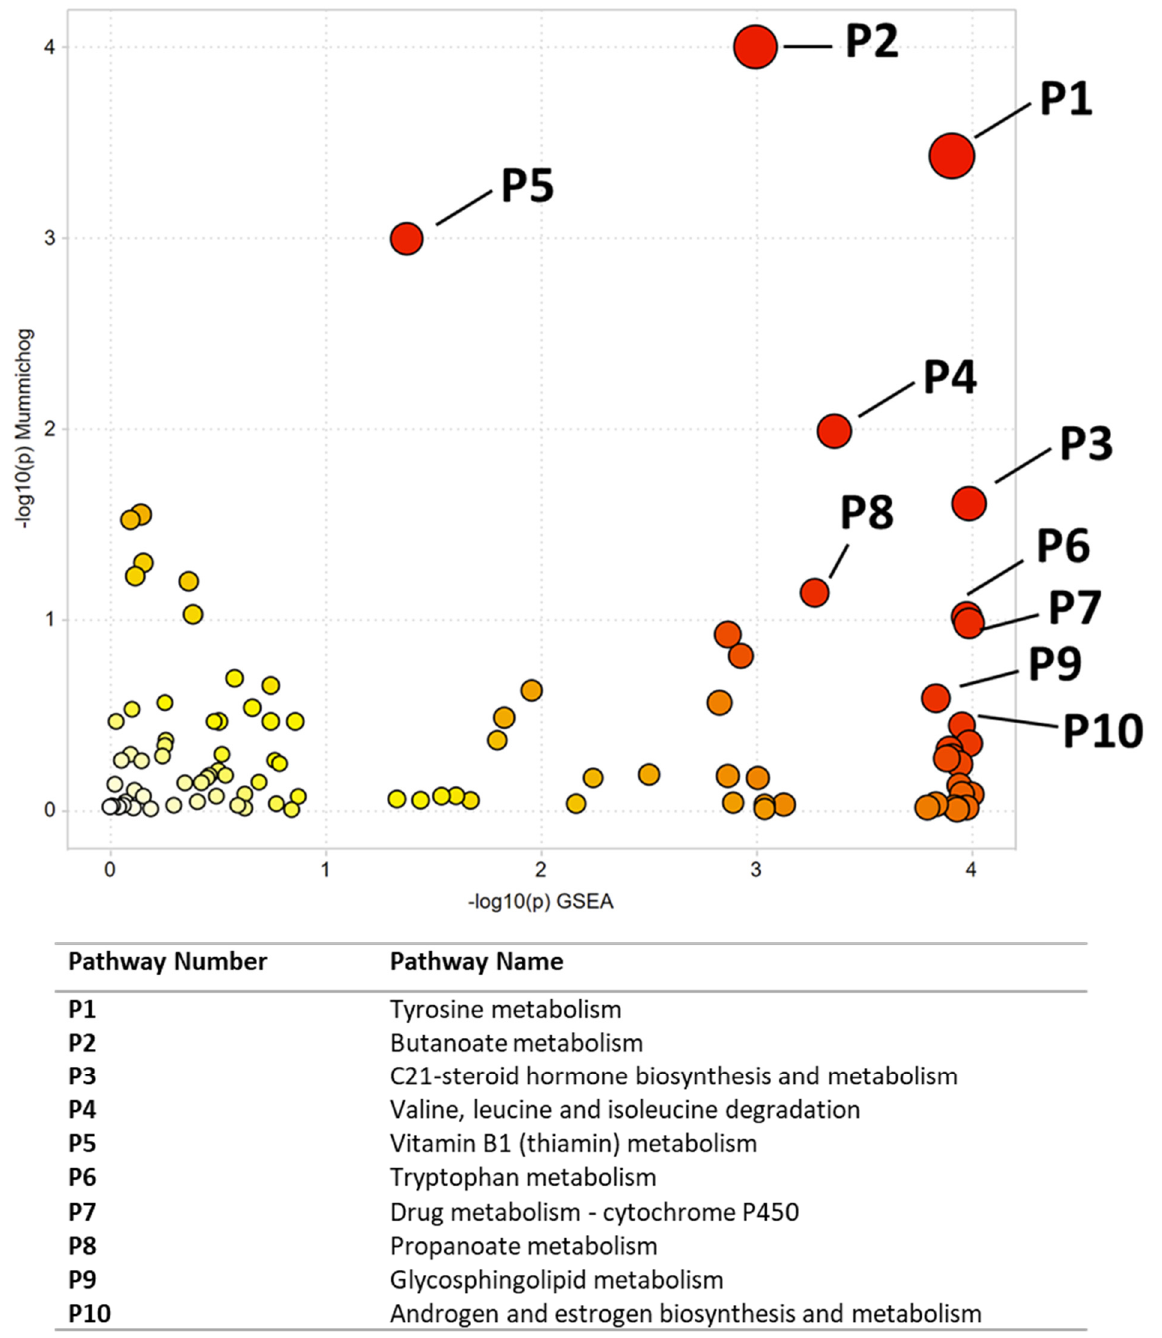
Figure 3. Pathway enrichment using Metaboanalyst for the comparison of NIST smoker and non- smoker urine reference material. All significant pathways are listed in Table 3. Darker circles represent pathways with a lower p -value. Larger circles indicate a higher number of significant metabolite hits relative to the total pathway size.